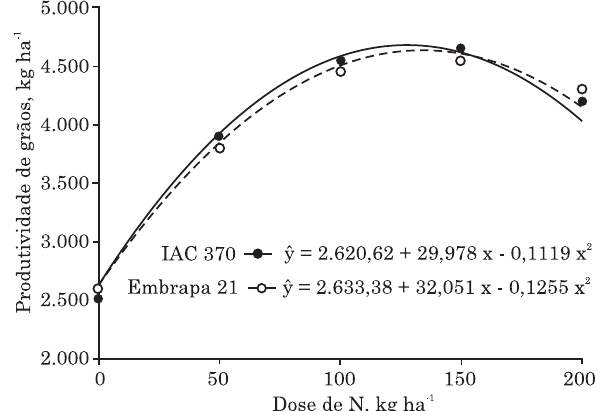
Figura 2. Produtividade de grãos de dois cultivares de trigo (IAC 370 e Embrapa 21), em resposta a diferentes doses de N aplicadas; médias de duas épocas de aplicação (na semeadura e em cobertura) e de três fontes de N (Entec®, sulfato de amônio e ureia). Produção máxima de 134 e 128 kg ha -1 para IAC 370 e Embrapa 21,